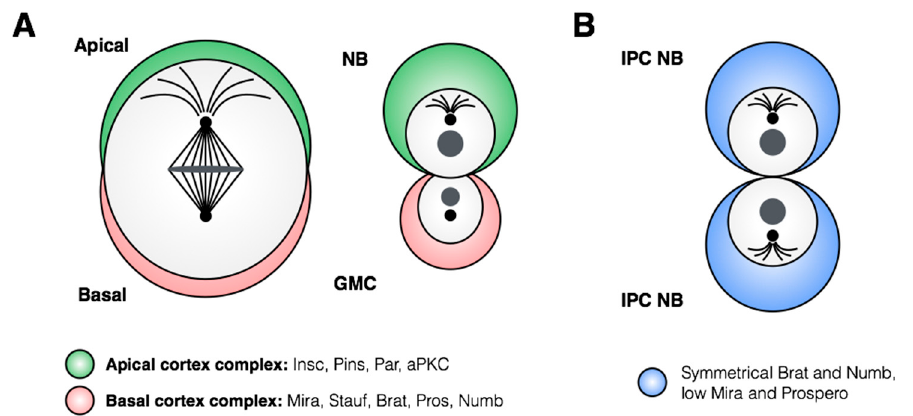
Figure 5. Localization of proteins during asymmetric and symmetric neuroblast divisions. ( A ) A typical asymmetric neuroblast division involves segregation of apical and basal cortex complex members to opposite sides of the dividing neuroblast. Proteins within the apical cortex complex are retained in the stem cell, while factors associated with the basal cortex complex are transmitted to the daughter GMC. ( B ) Symmetric divisions of the IPC neuroblasts display low Prospero and Miranda protein levels, but Brat and Numb proteins are divided equally between the two new stem cells [51].